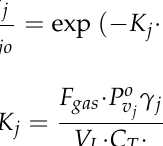
Table 2. Parameters obtained from the fitting of P o v obtained from variance analysis. Coefficient of variation (R 2 ), Fischer’s test value (F-value), and probability ( p -value) are also